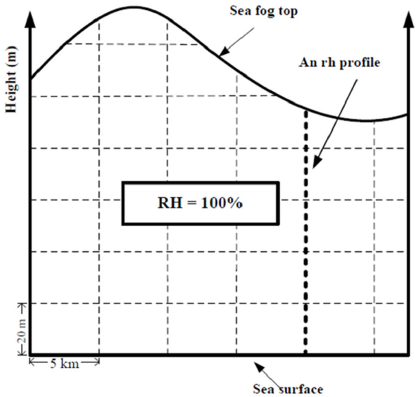
Figure 3. Schematic diagram for discretizing satellite-derived humidity within the observed fog in a vertical cross-section. The bold dash line represents an RH profile. Information from such soundings is used to allocate sea fog humidity data to a grid with the horizontal and vertical grid intervals of 5 km and 20 m, respectively. This figure is duplicated from W14. The GSI package provides the corresponding observation errors. In this study, the observation errors range from 0.6 to 3.8 g kg − 1 for the satellite ‐ derived humidity. GSI per ‐